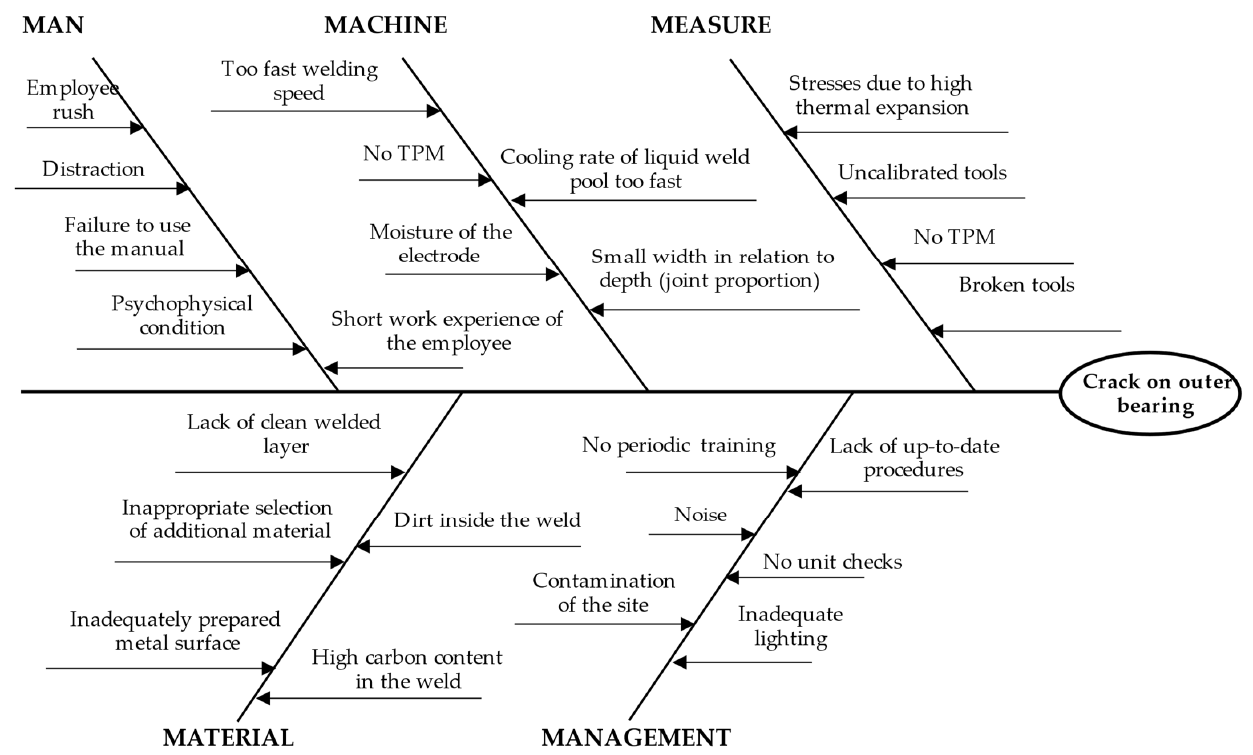
Figure 4. Ishikawa diagram for a crack in the bearing